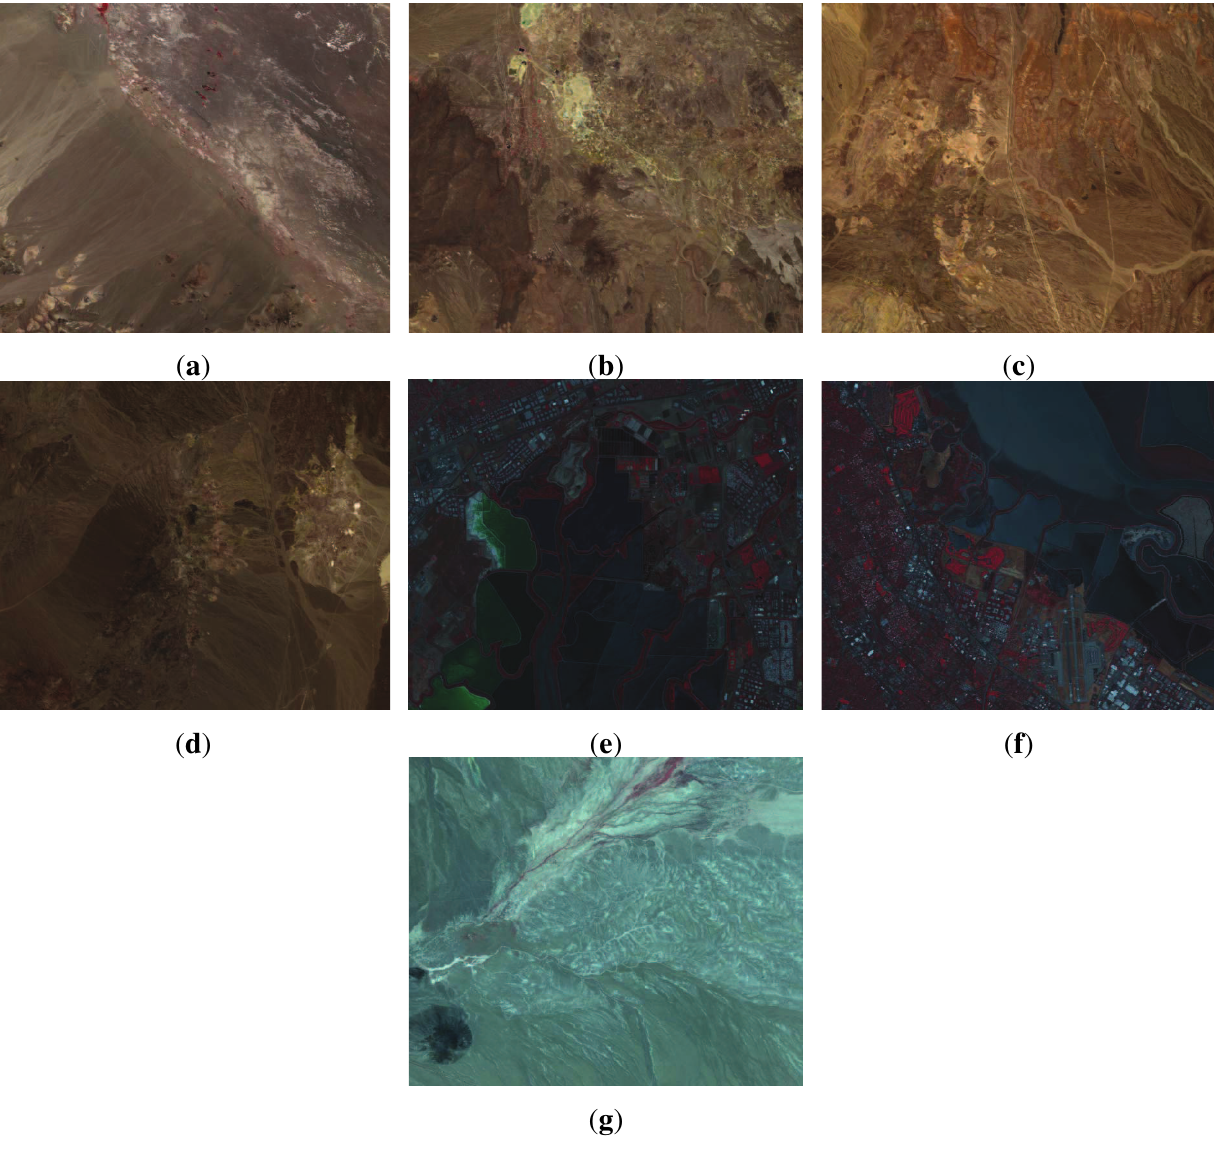
; ( b ) 01 _ igm ; and ( g ) 03